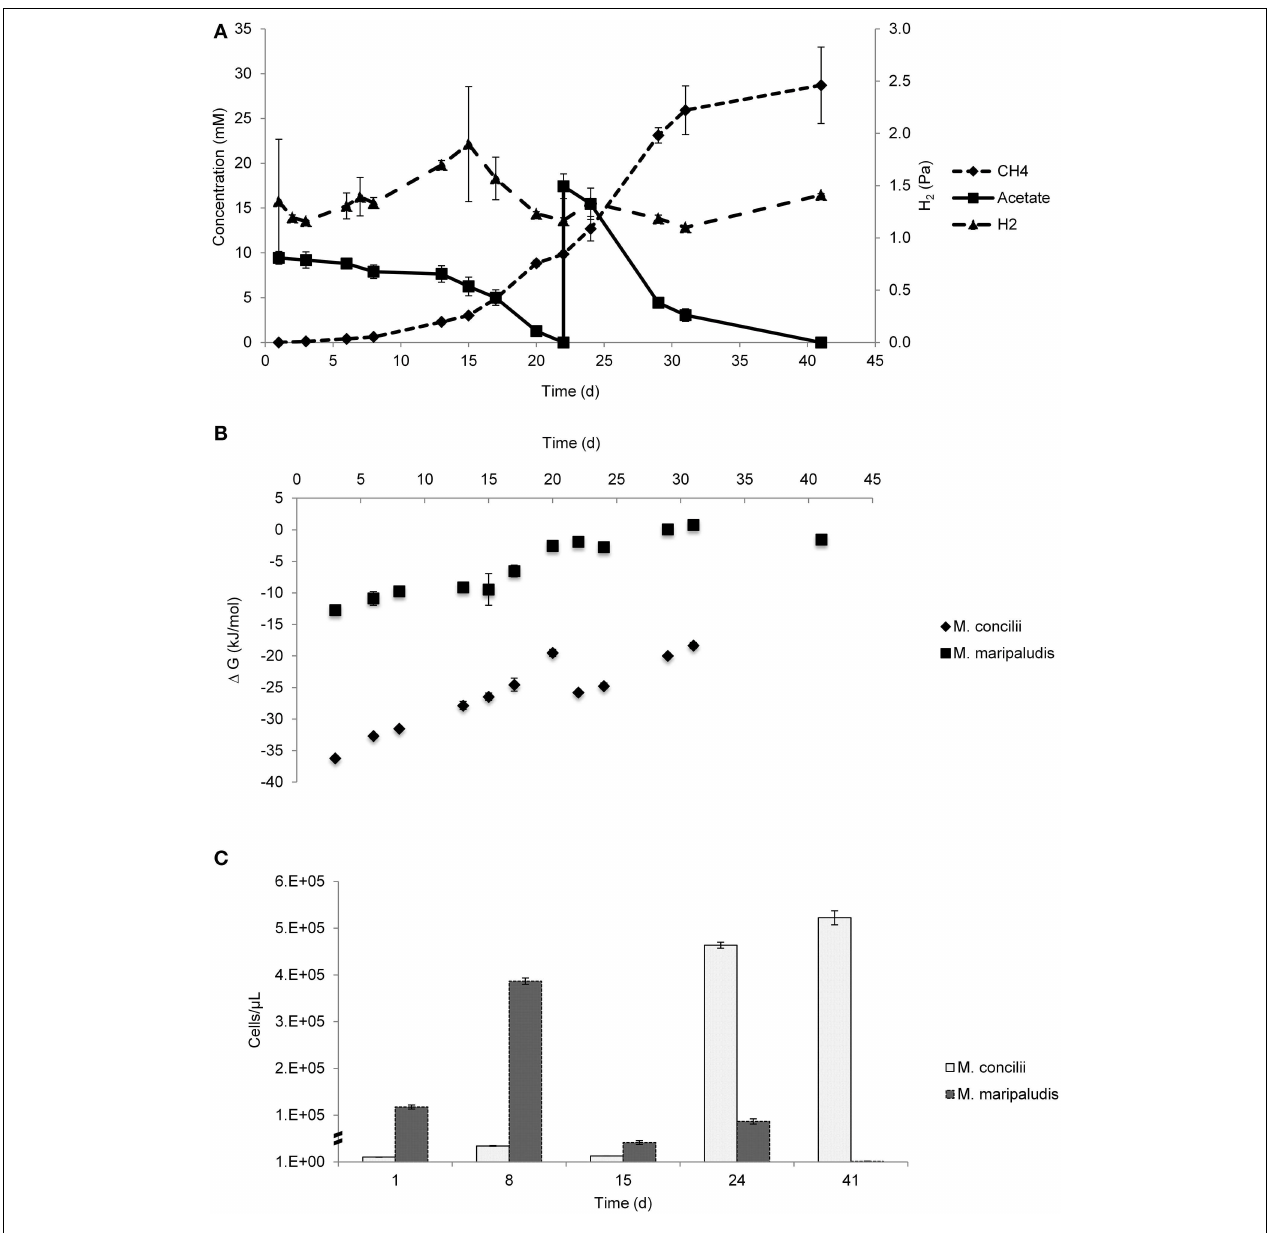
degradation to methane formation from acetate. (C) Growth quantified by qPCR in cells/ µ l expressed. All data is average of 2 replicate